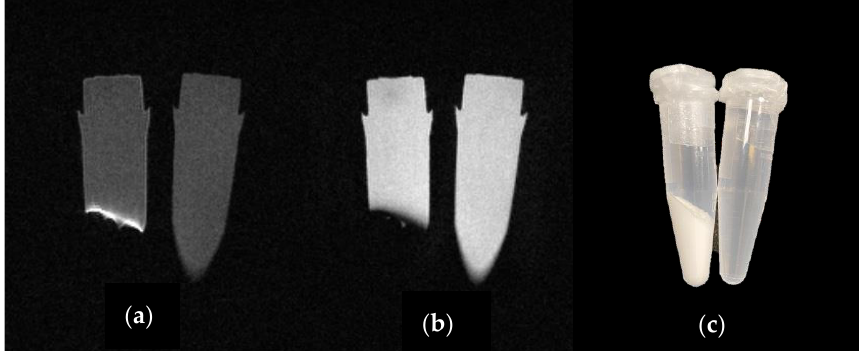
Figure 4. At 1 Tesla, GdPO 4 phantom shows enhancement at the solution solid interface. ( a ) T 1 -weighted spin echo image (TR/TE = 350/13.1 ms), ( b ) T 2 -weighted spin echo image (TR/TE = 1600/120 ms), ( c ) A photo of the microcentrifuge tubes making up GdPO 4 phantom: the tube on the right contains deionized (DI) water, the one on the left contains a GdPO 4 precipitate in DI water after centrifugation.